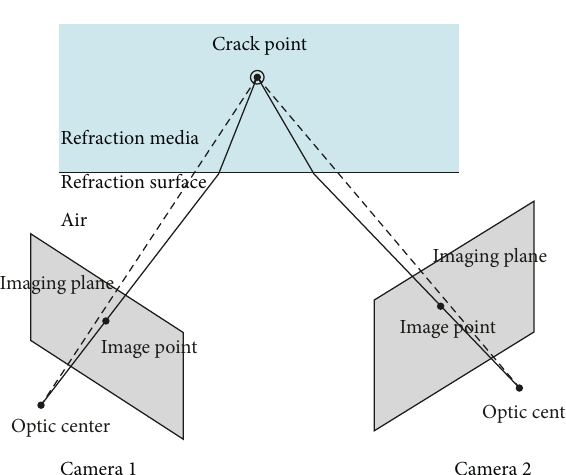
Figure 7: The triangular principle considering the refraction